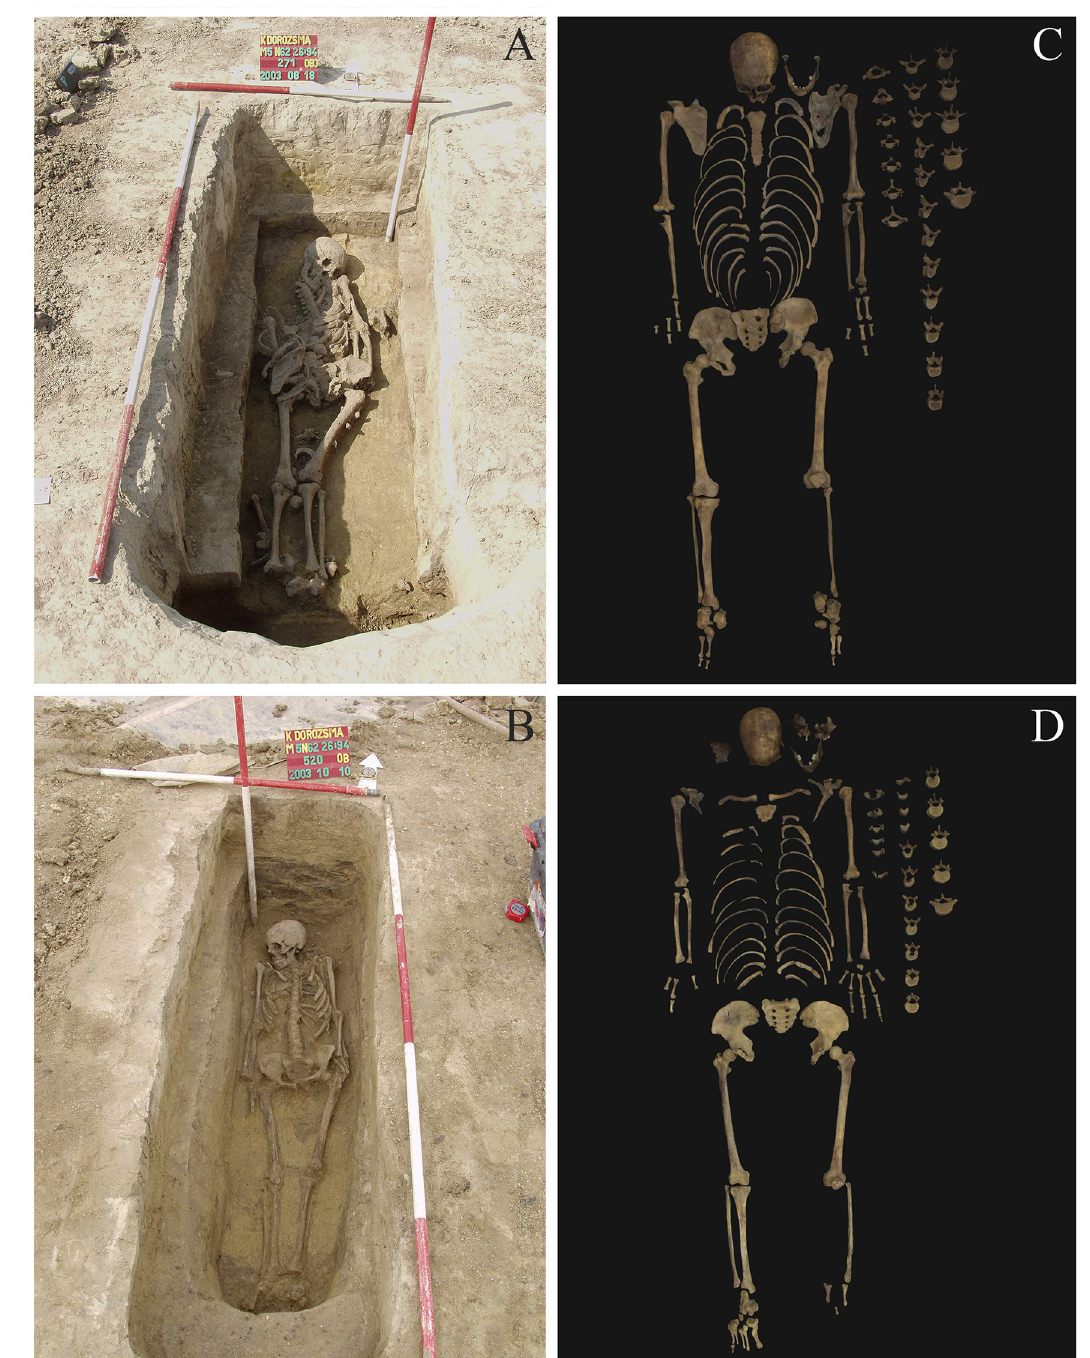
Fig 2. Photos of the burials of A) KD271 and B) KD520 in situ , and photos indicating the completeness of the skeletons of C) KD271 and D) KD520.